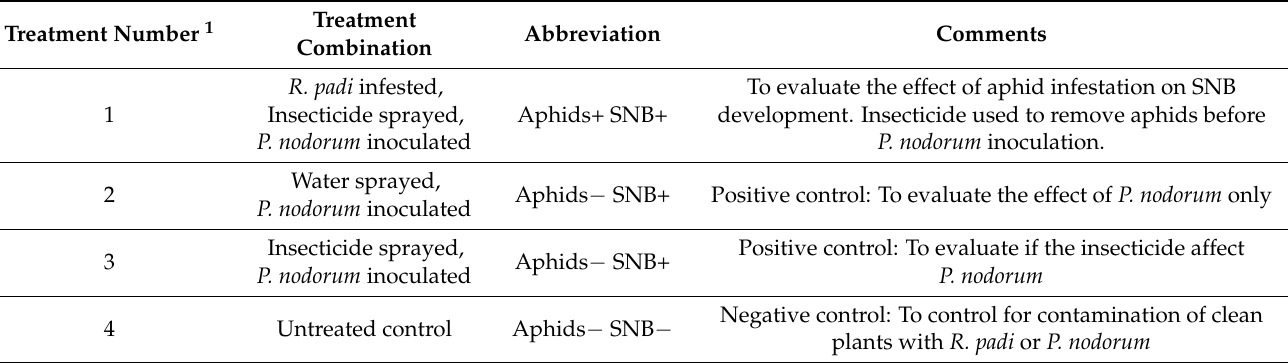
Table 1. Treatments and combinations in the experiment on interaction between Rhopalosiphum padi (cherry-oat aphid) and Parastagonospora nodorum (stagonospora nodorum blotch) on whole wheat plants. Treatment Number